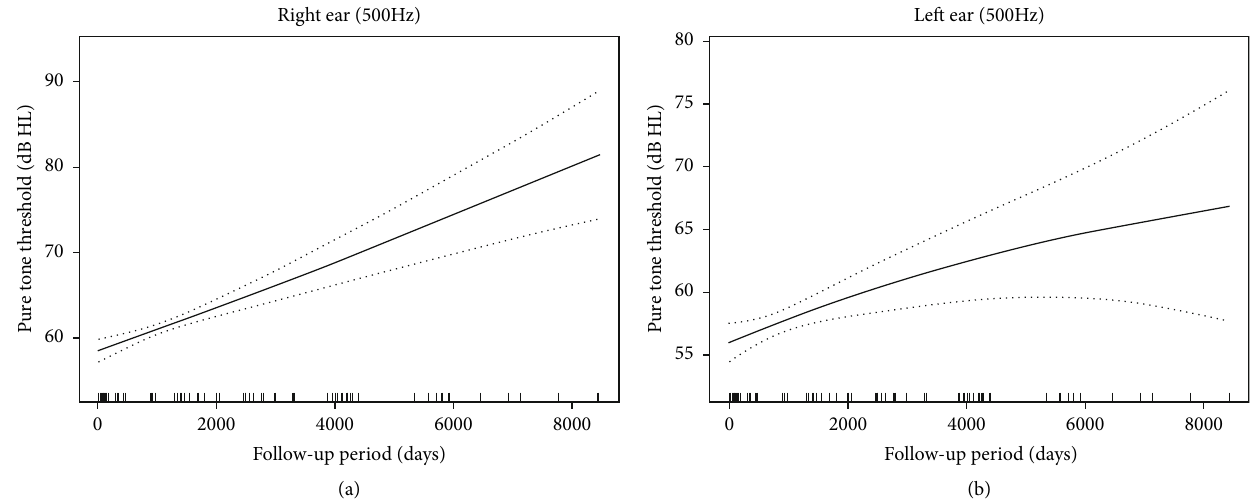
Figure 5: (a, b) The change of pure tone threshold of 0.5kHz over time in both ears of AIFM1 -positive AN patients. Spline smoothing was performed using GAMM (generalized additive mixed model) to explore the change of pure tone threshold with the length of follow-up time. The solid lines represent the fi tting spline. The dashed lines represent the 95% con fi dence intervals. The vertical axis measures the change in pure tone hearing. The rug plot provides a visual representation of the frequency distribution for follow-up time. Each individual data point is represented by a single tick mark at the appropriate location on the chosen time scale (days).